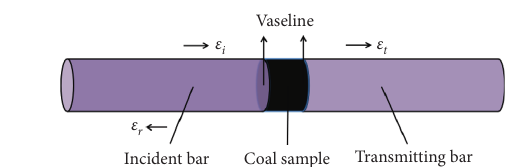
Figure 2: Picture of the placed coal sample and pressure bars.